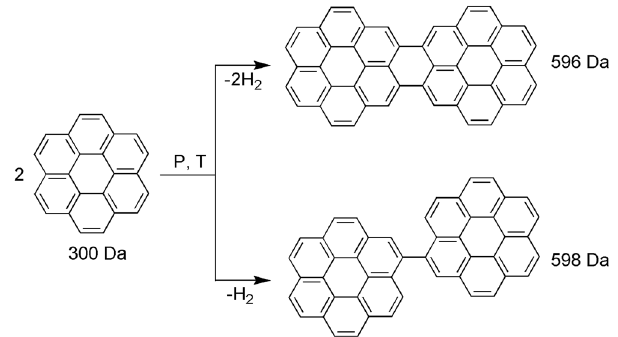
Figure 4. Dimerization of coronene at high pressure and temperature via dehydrogenation and formation of new carbon-carbon bonds.